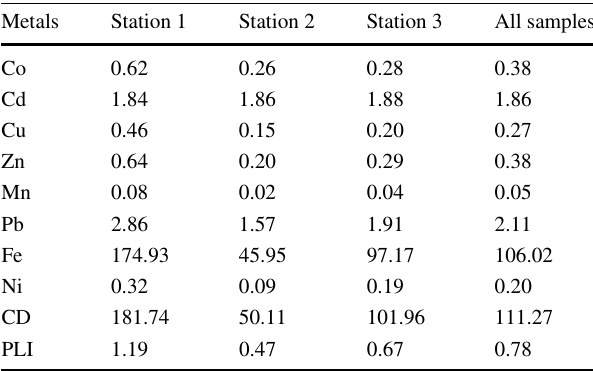
Table 2 Calculated contamination degree (CD) and Pollution